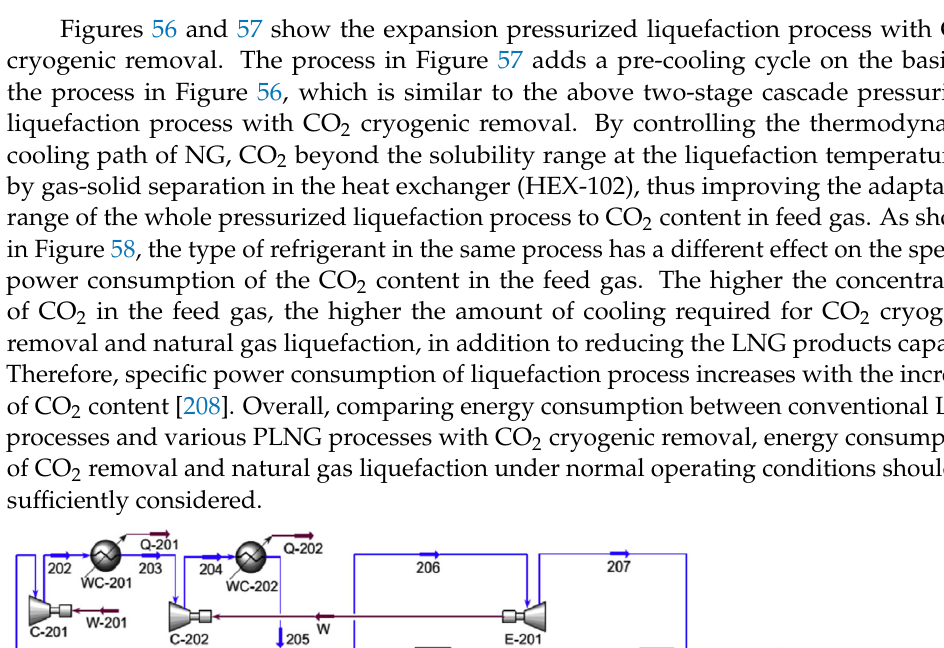
Figure 55. C 2 H 4 -C 3 H 8 PLNG process with CO2 cryogenic removal [207].